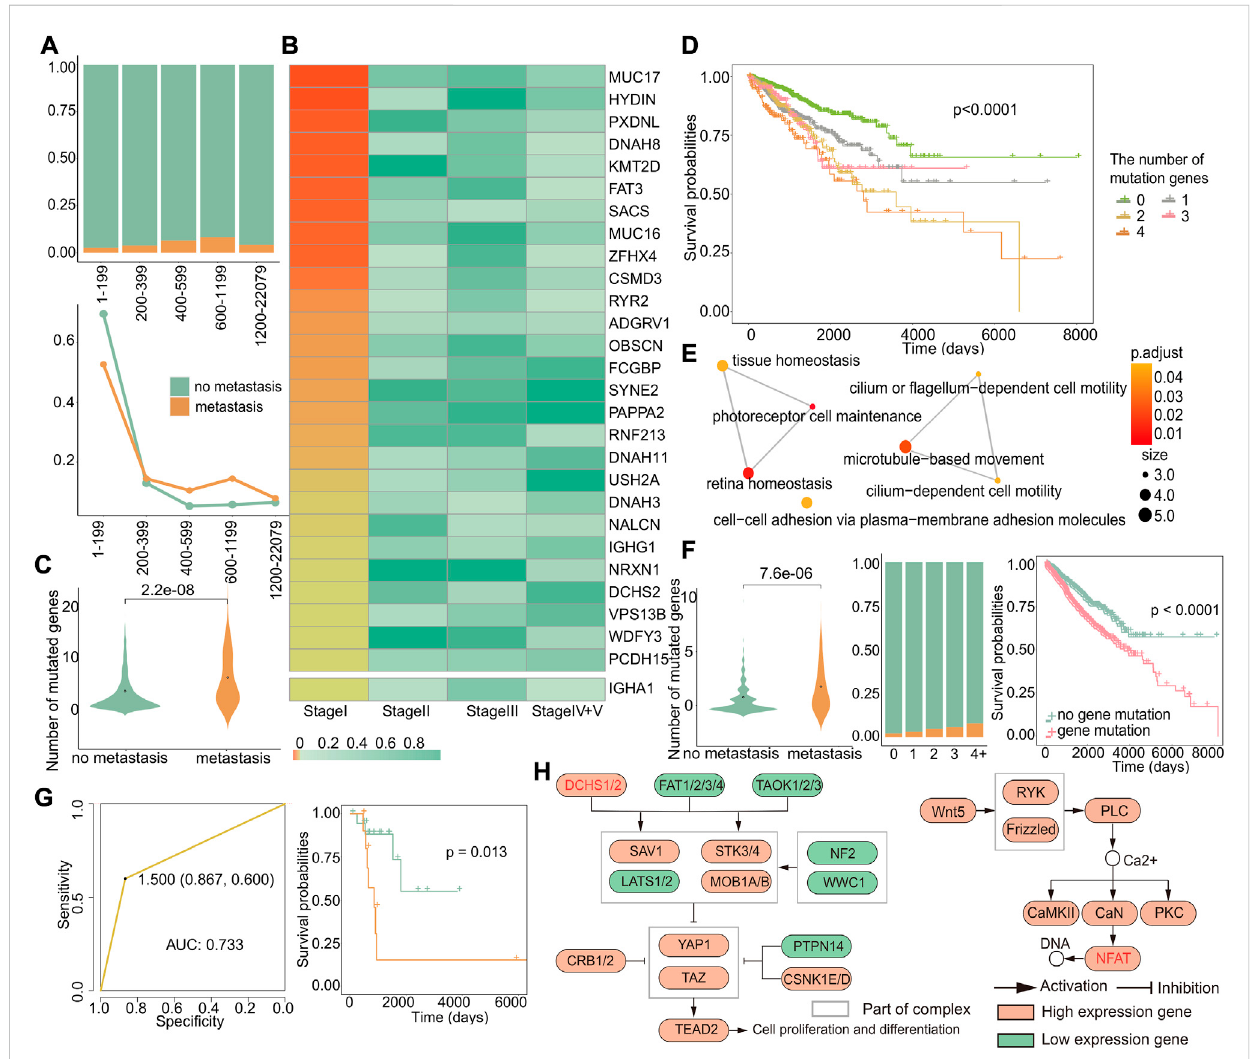
Genes speci fi cally mutated in early metastasis. (A) The distribution of primary and metastatic tumors in different mutation number groups (up). Changesinthedistributionofprimaryandmetastatictumorsinthetotalprimaryandmetastatictumorsindifferentmutationgroups(down).Theabscissa represented groups with different numbers of mutant genes. (B) Heatmap of Fisher ’ s exact test p -value of mutant genes related to speci fi c metastasis in stage I. (C) For these 28 genes, the difference in the number of mutations between the primary and metastatic tumor. (D) Kaplan – Meier survival curves of samples with different numbers of mutations. (E) GO enrichment analysis of 28 genes. Each dot represents a pathway, and the connecting two points mean that the same genes were in the pathways. (F) For these 12 genes, left: difference in number of mutations between primary and metastatic tumor samples; middle: the proportion of primary and metastatic tumors in groups with a different number of mutations, where green was the primary tumor andyellowwasthemetastatictumor;andright:survivaldifferencesinsamples withorwithoutgenetic mutations. (G) Basedon12 genes, theROC curve of the classi fi er constructed by k-nearest neighbors and the Kaplan – Meier survival curve of the result of the classi fi er. Yellow indicates samples predicted to develop metastasis, and blue indicates samples predicted to have no metastasis. (H) KEGG enrichment analysis of 12 genes. Related genes are marked in